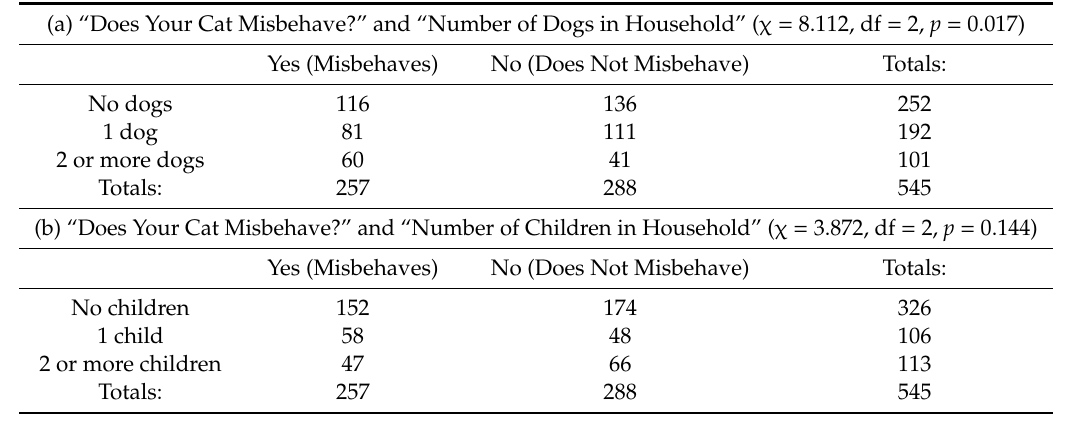
Table 6. Contingency tables for household demographics and owner-reported misbehavior (yes /